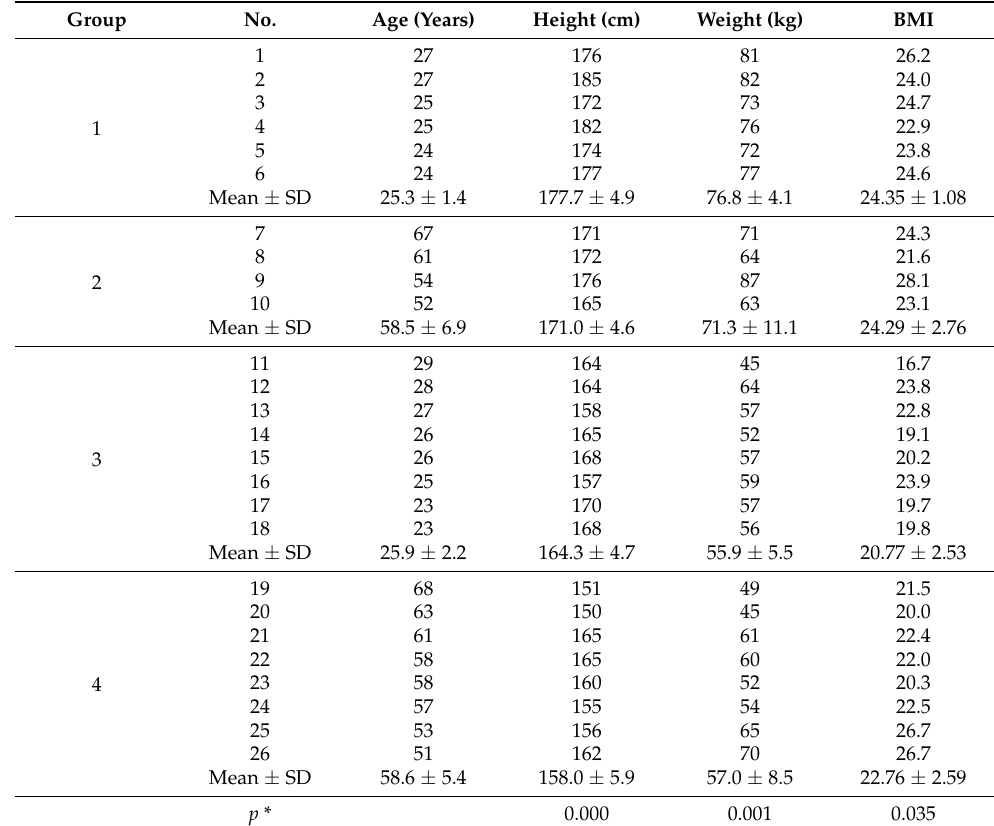
Table 1. Characteristics of individual study participants. Group No. Age